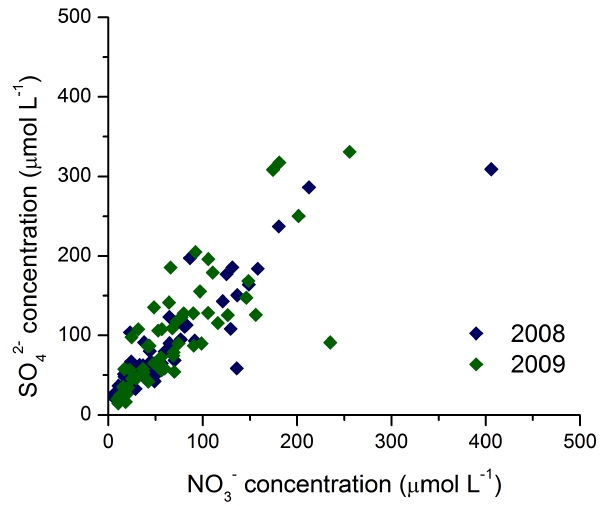
Fig. 7. NO − concentration vs. SO 2 − concentration in precipitation 3 4 collected in 2008 to 2009 in Guangzhou City. R 2 = 0 . 80, P < 0 . 001 in 2008; R 2 = 0 . 77, P < 0 . 001 in